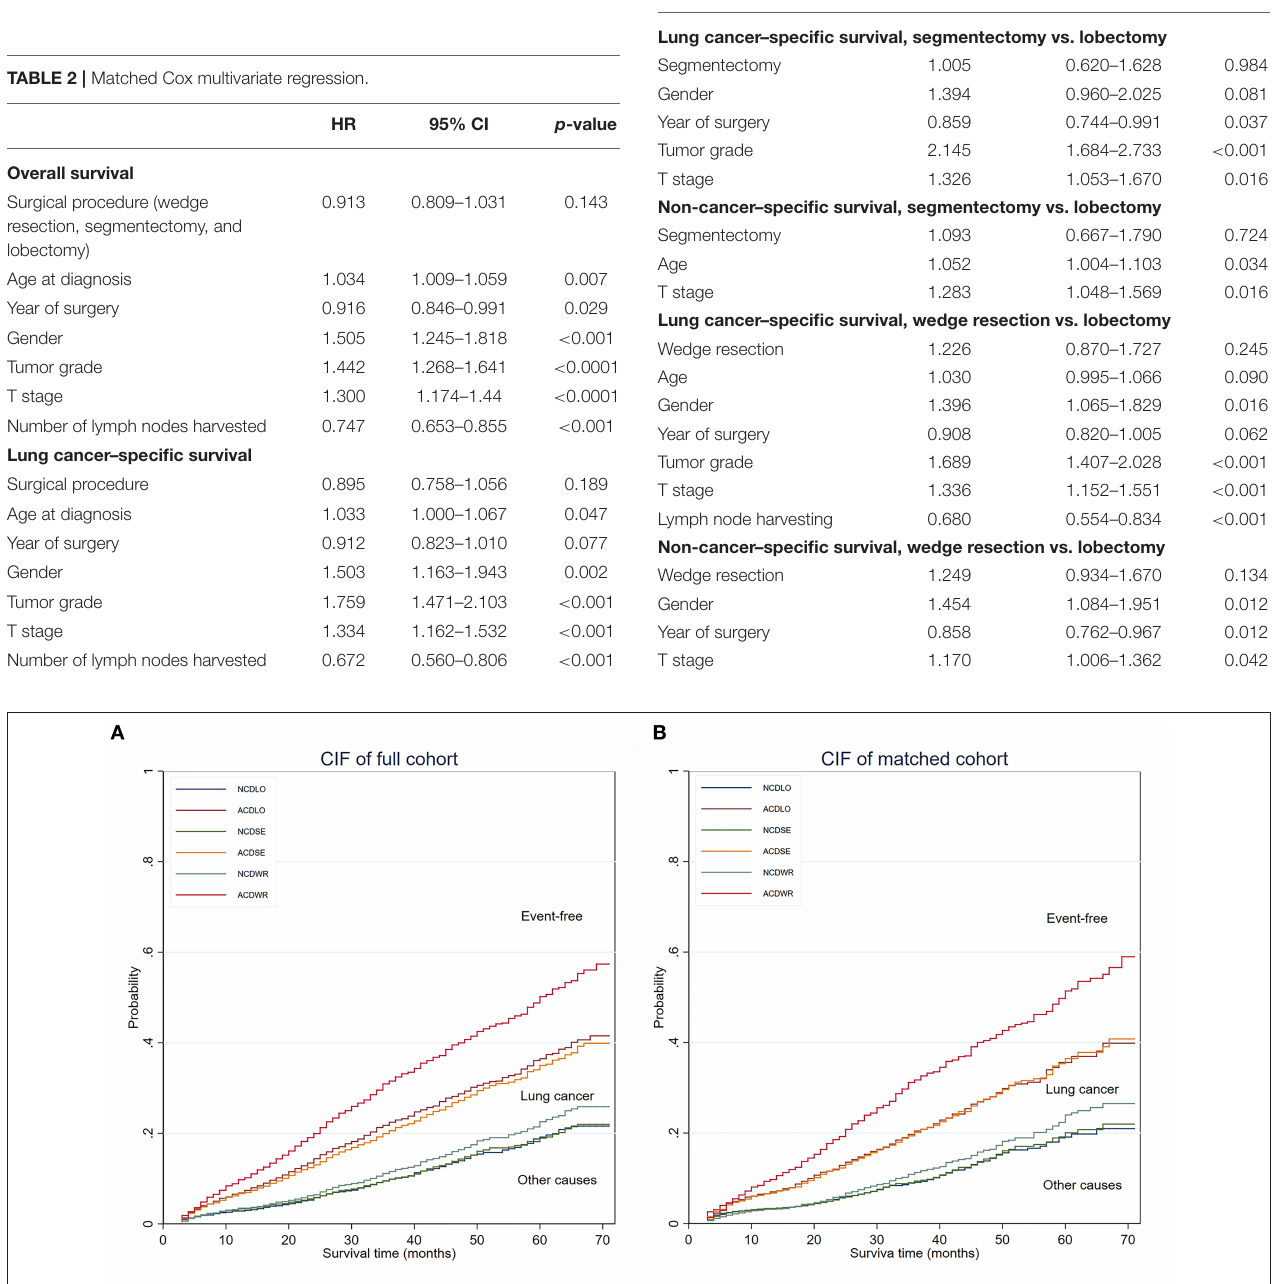
FIGURE 2 | CIF of the full cohort and PS matched cohort. (A) CIF of the full cohort. (B) CIF of the PS-matched cohort. The area below the non-cancer–related death incidence function was defined as the cumulative incidence of non-cancer–related death, the area between the non-cancer–related death incidence function, and the all-cause death incidence function was defined as the cumulative incidence of lung cancer–related death, and the area above the all-cause death incidence function was defined as the cumulative incidence of being event free. CIF, cumulative incidence function; NCD, non-cancer–related death; ACD, all-cause death; PS, propensity score; WR, wedge resection; SE, segmentectomy; LO, lobectomy.